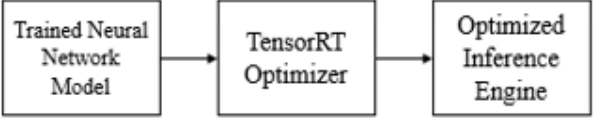
Figure 7. Model optimization workflow using TensorRT.